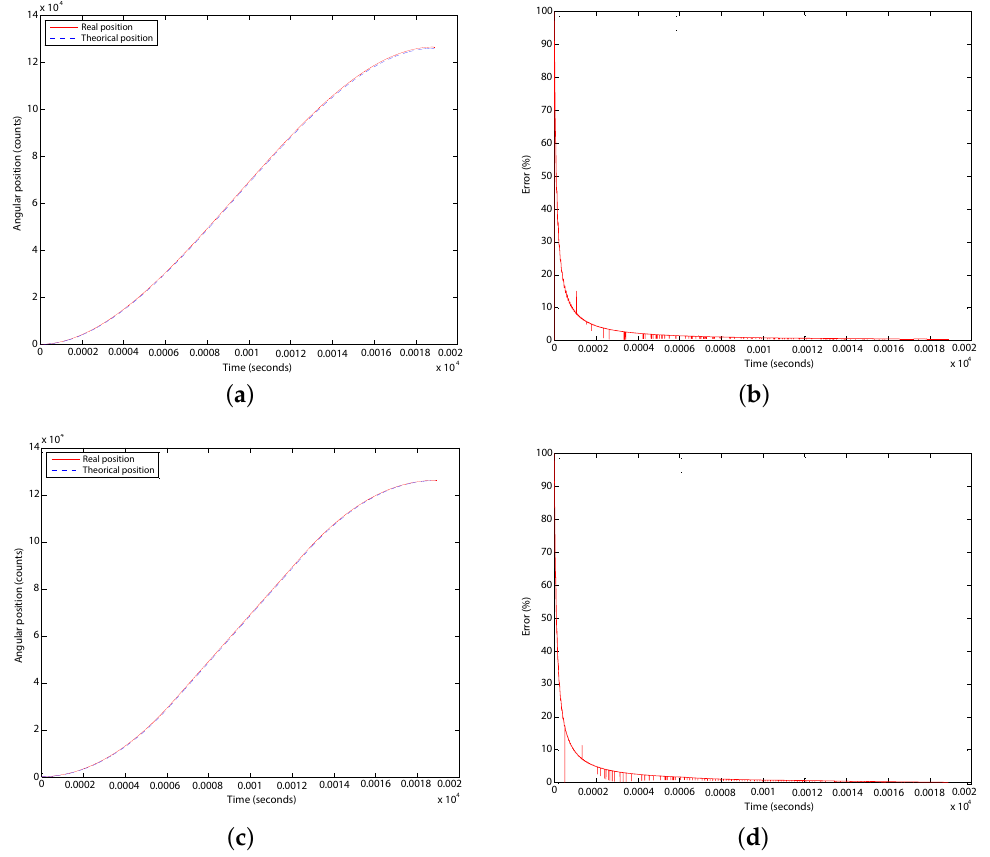
Figure 9. Experimental comparison of the position control of both profiles for 15 turns. ( a ) Parabolic velocity profile. ( b ) Parabolic error. ( c ) Trapezoidal velocity profile. ( d ) Trapezoidal